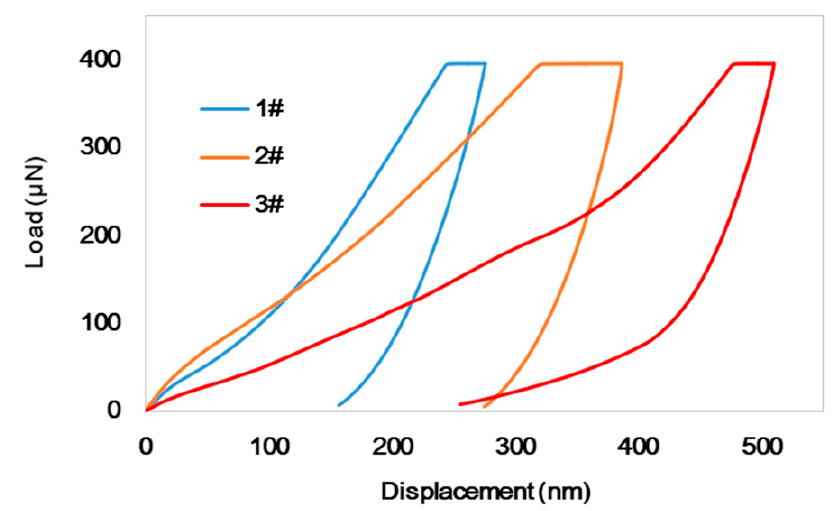
Figure 2. Typical NI load–displacement curves of the three degraded wood samples. Table 3. Nanoindentation test results of the three different degraded wood samples. Wood Samples Elastic Modulus